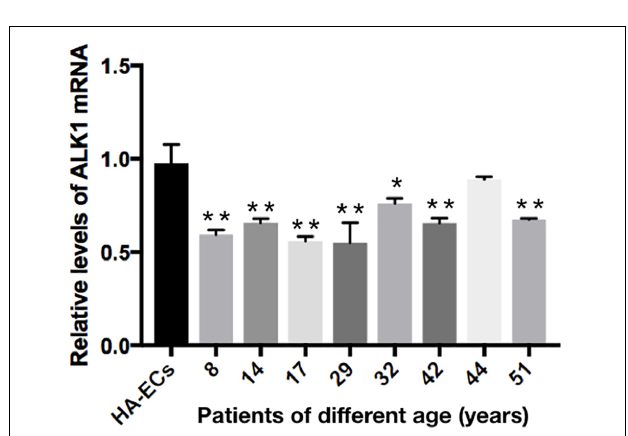
FIGURE 7 | Proliferative ability of HA-ECs and cAVM-ECs with different ages. HA-ECs and cAVM-ECs derived from eight patients were successfully passaged to the forth generation. The results showed that the number of HA-ECs was (0.527 ± 0.065) million, which was less than that in cAVM-ECs from (patient 8-year-old) (0.877 ± 0.06) million and cAVM-ECs from (patient 14-year-old) (0.697 ± 0.061) (all ∗ p < 0.05).